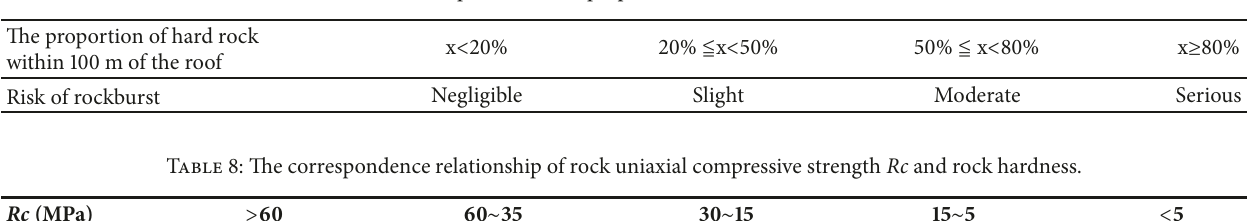
Table 7: Relationship between the proportion of hard rock and rockburst risk.